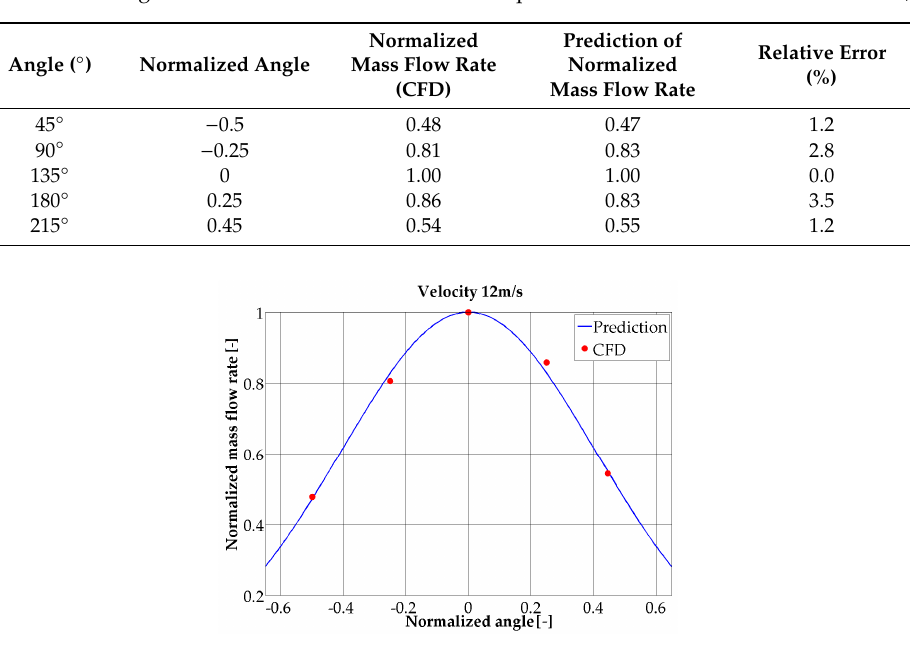
Energies 2019 , 12 , 1600